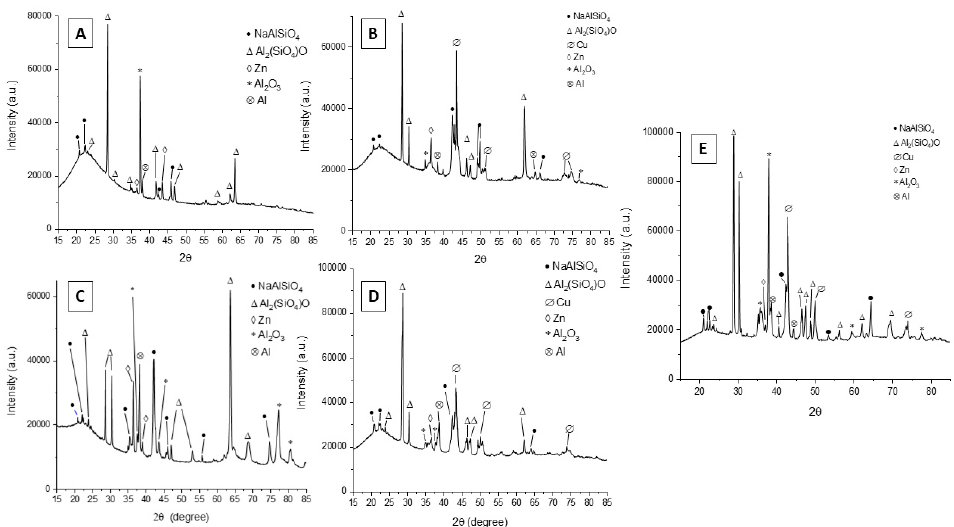
Figure 7. X-ray diffraction patterns of the samples obtained working at 0.5 A/cm 2 in DC mode with- out particles ( A ) and with large particles ( B ) and working at 1 A/cm 2 in UPC without particles ( C ), with large particles ( D ) and with small particles ( E ). Sample obtained at 0.5 A/cm 2 in DC with small particles not reported due to failure of the coating.